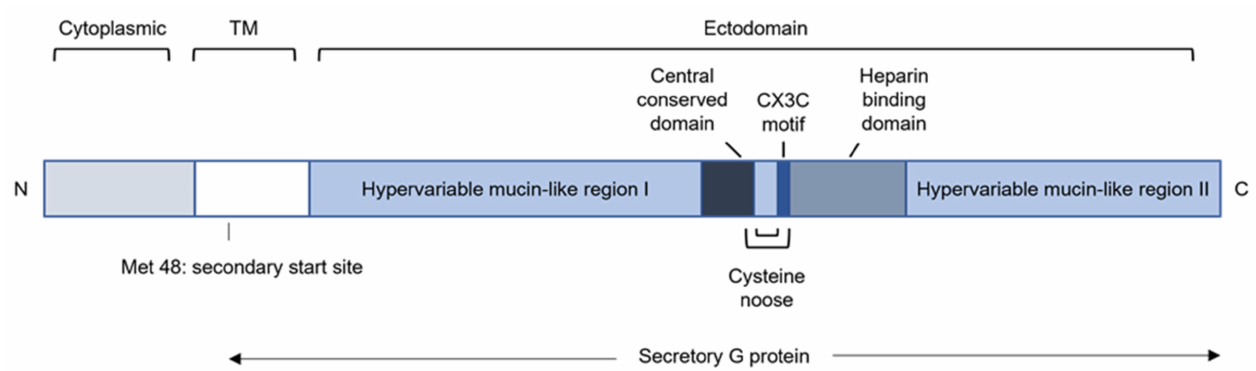
Figure 7. Schematic representation of the RSV G protein. The cytoplasmic and transmembrane (TM) domains of mG are localized at the N-terminus. The ectodomain includes two mucin-like regions that are separated by a central conserved domain that forms 2 disulfide bridges with the adjacent region, resembling a cysteine noose. The CX3C motif and heparin-binding domain are also part of the large ectodomain. Synthesis of secretory G protein occurs through translation initiation at the second start codon at position